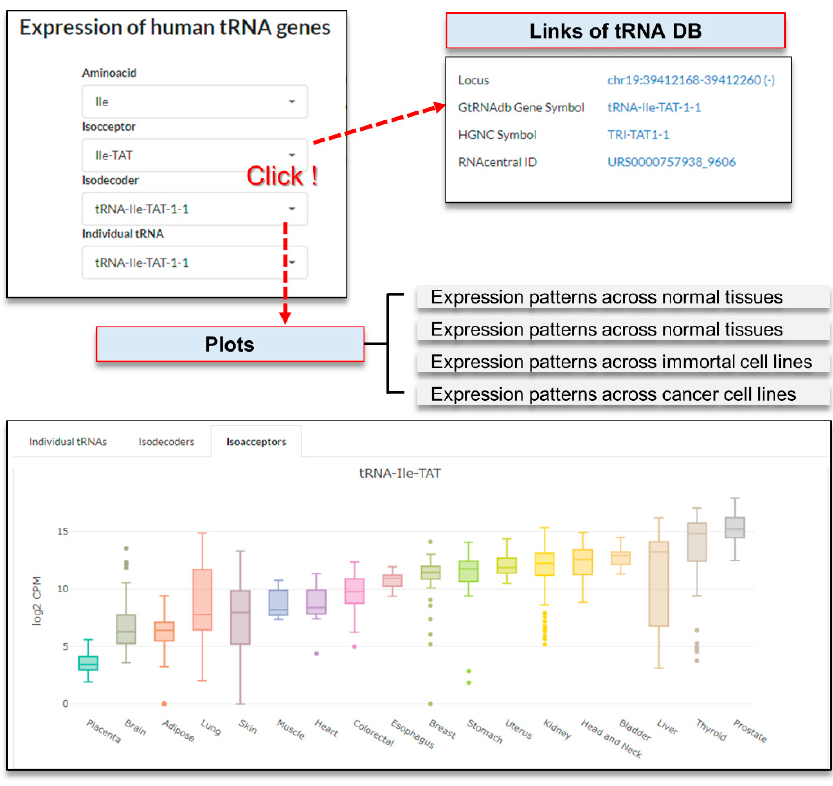
Figure 5. The ‘Explore tRNAs’ page.